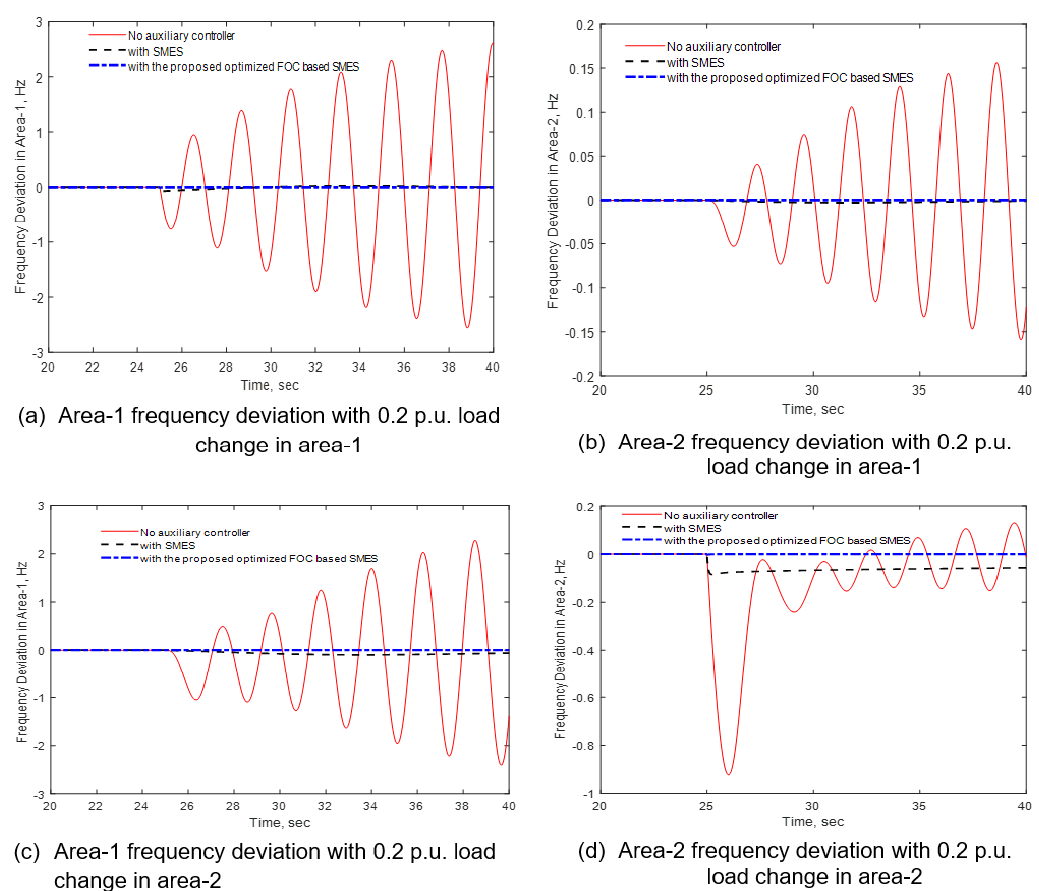
Figure 15. Frequency response for both areas for step load change with 50% reduced inertia.